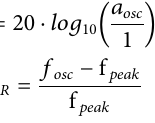
Frontiers in Electronics |